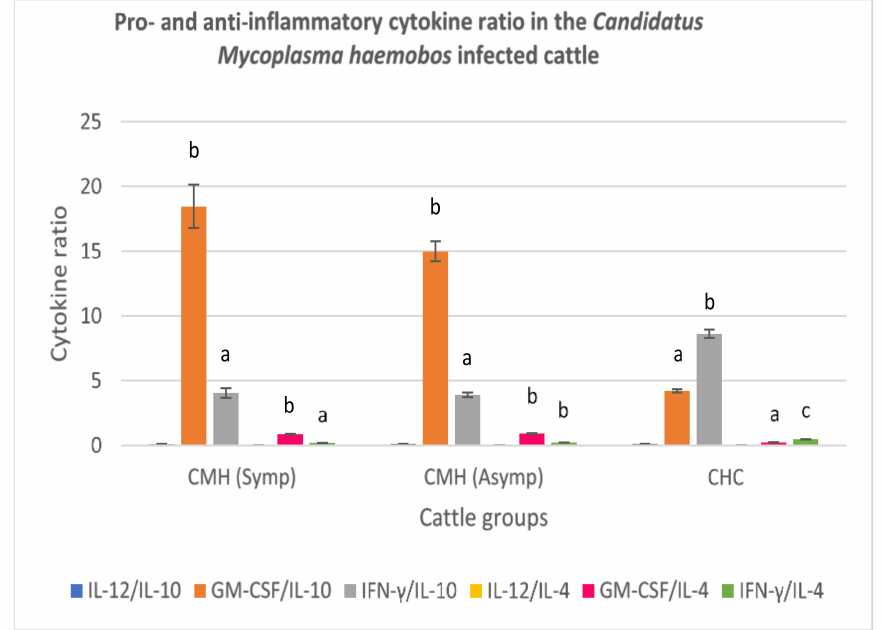
Figure 1. Pro- and anti-inflammatory cytokine ratio in symptomatic and asymptomatic cattle nat- urally infected with Candidatus Mycoplasma haemobos. Molecular detection and confirmation of the blood parasite was by PCR amplification of 16S rRNA gene. Candidatus Mycoplasma haemobos infected symptomatic cattle had the highest serum GM-CSF:IL-10 cytokine ratio. Low IL-12:IL-10, IL-12:IL-4, IFN- γ :IL4 ratios were significant findings in both symptomatic and asymptomatic C. M. haemobos infected cattle. CMH (Symp): Symptomatic Candidatus Mycoplasma haemobos infected cattle; CMH (Asymp): Asymptomatic Candidatus Mycoplasma haemobos infected cattle; CHC: Clinically healthy cattle (control). IL-12: Interleukin 12; IL-10: Interleukin 10; GM-CSF: Granulocyte Macrophage-colony stimulating factor; IFN- γ : Interferon gamma; IL-4: Interleukin 4. ( a – c ) Different superscripts refer to significant differences in the parameters between C. M. haemobos infected cattle and clinically healthy cattle ( p <